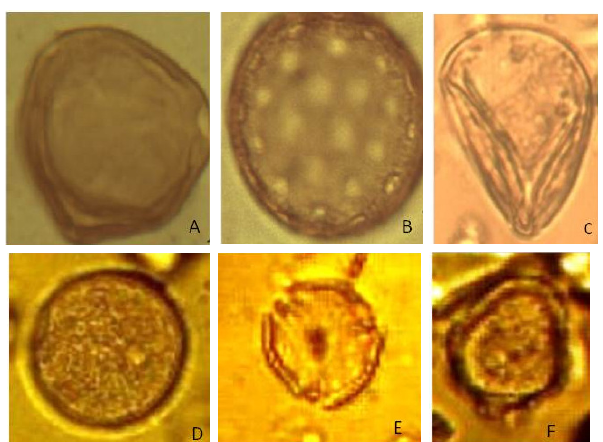
Fig. 6. Recovered palynomorphs: a. Ludwigia sp.; b. Amaranthaceae; c. Cynodon dactylon ; d. Panicum maximum ; e. Alchornea cordifolia ; f.